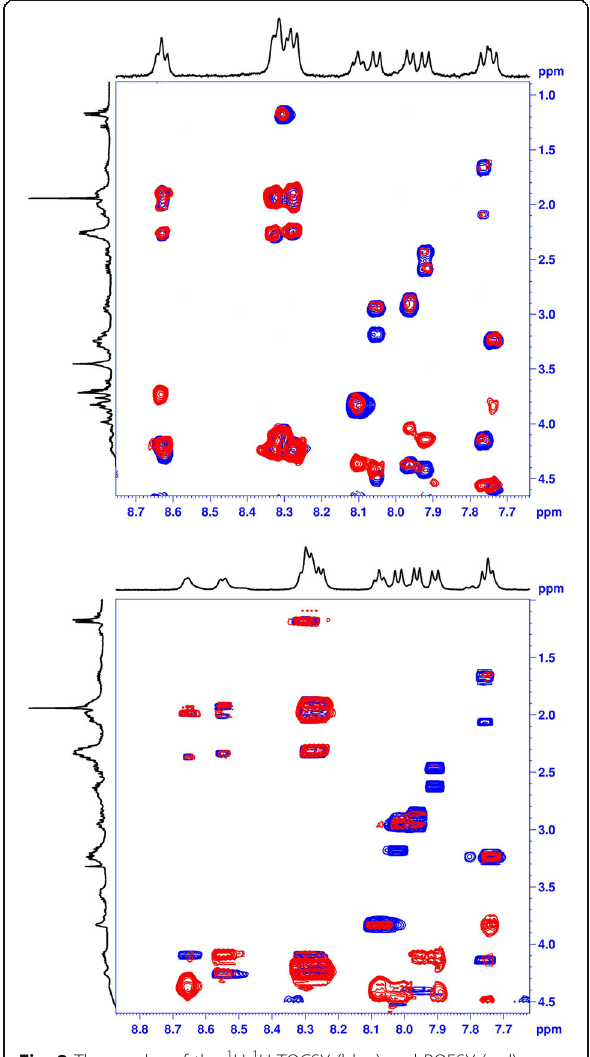
Fig. 2 The overlay of the 1 H- 1 H TOCSY (blue) and ROESY (red) spectra of Ga 3+ -CP04 complex (upper spectra) and Lu 3+ -CP04 complex (lower spectra). The red spots with no blue ones below indicate ROESY correlations between distinct amino